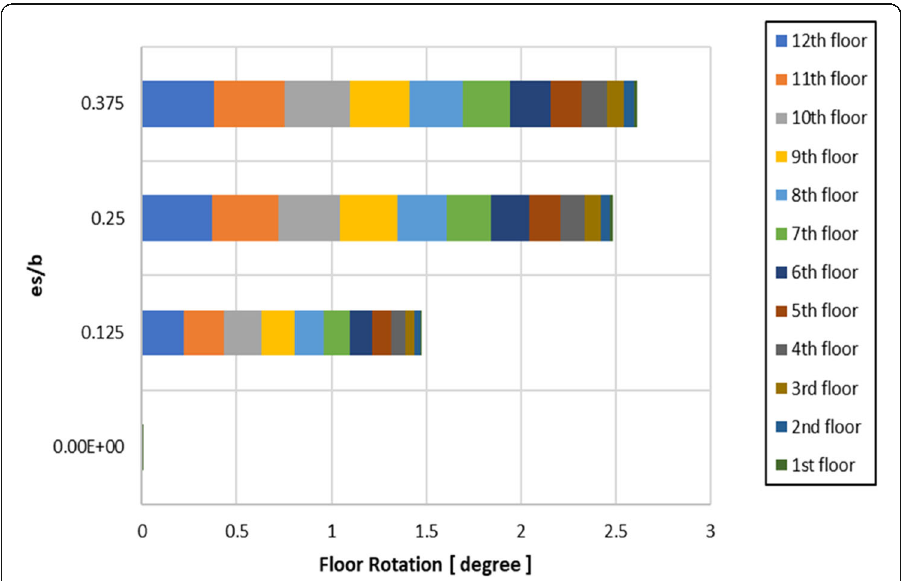
Figure 24: Comparison of es / b — floor rotations for DS-2-1, DS-2-2, DS-2-3, and DS-2-4 (color should be used for this